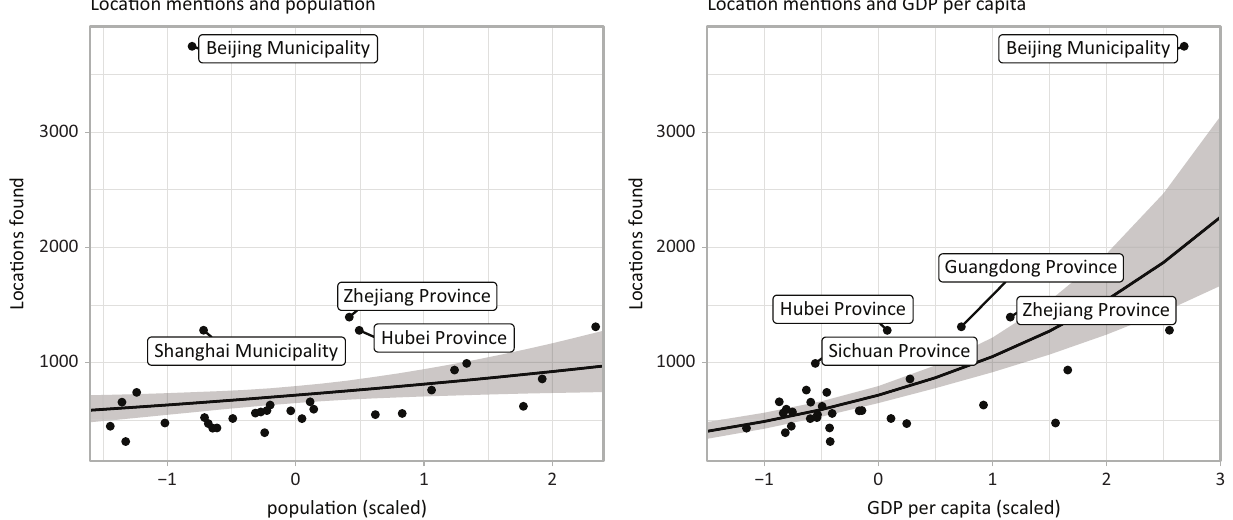
Figure 3. Marginal effects based on the Bayesian negative binomial regression model for population and GDP per capita. Note: Positive outliers are